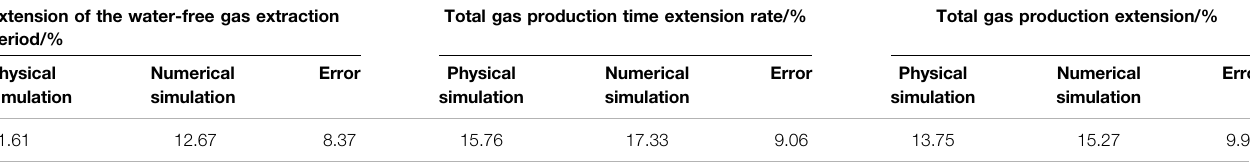
TABLE 6 | Comparison of error statistics between physical and numerical simulation results. Extension of the water-free gas extraction